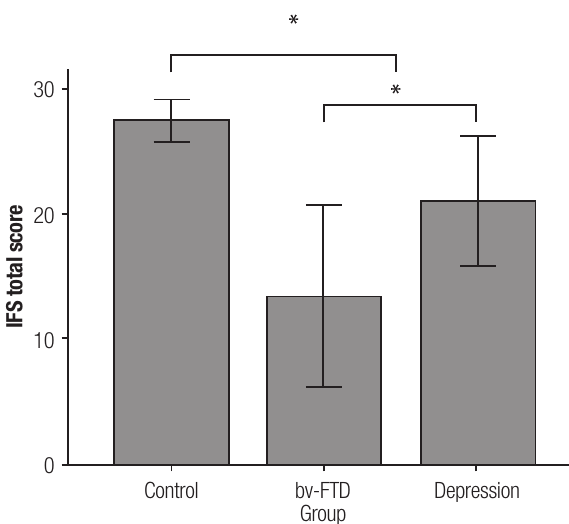
Figure 1. Comparison of IFS total score performance across groups. Error bars represent SD.